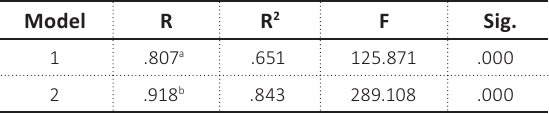
Table 5. Multiple hierarchical regression analysis Model